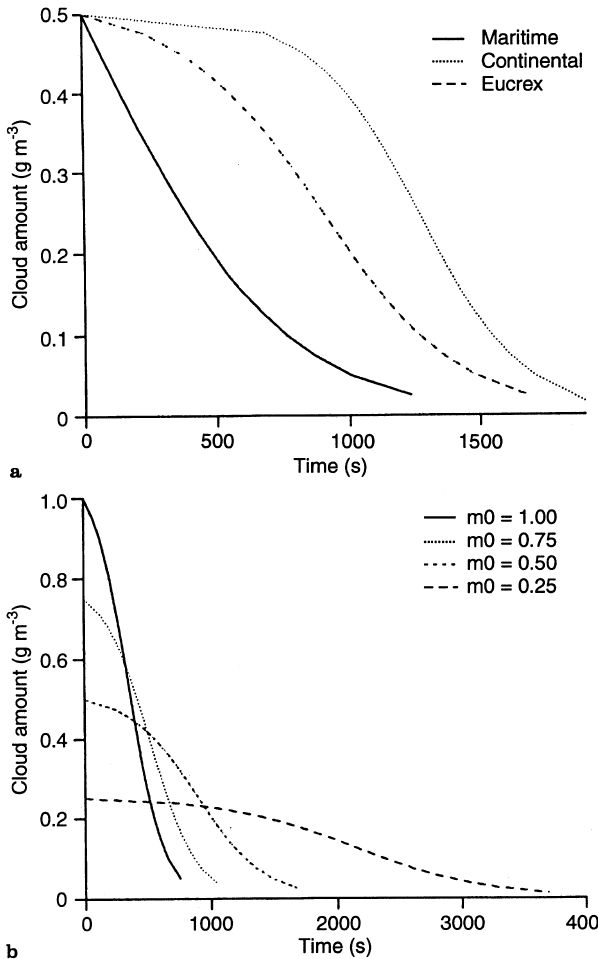
Fig. 3a, b. Time of onset of precipitation calculated from the analytical solutions of Eqs. (16) and (17) using the Berry (1968) scheme. a Cloud water content for di(cid:128)erent cloud types. b E(cid:128)ect of varying initial cloud water content with N b (cid:24) 200cm (cid:255) 3 , D b (cid:24) 0 :